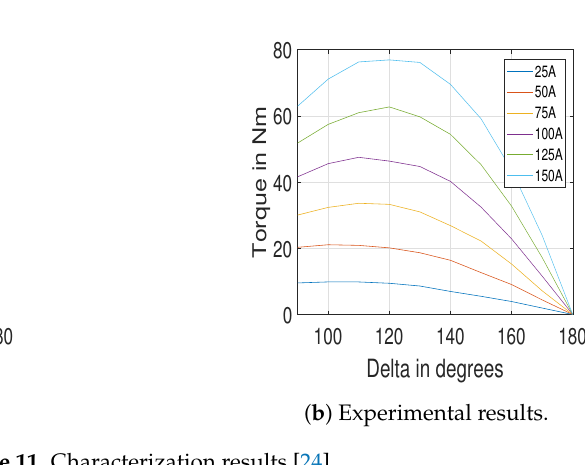
Figure 11. Characterization results